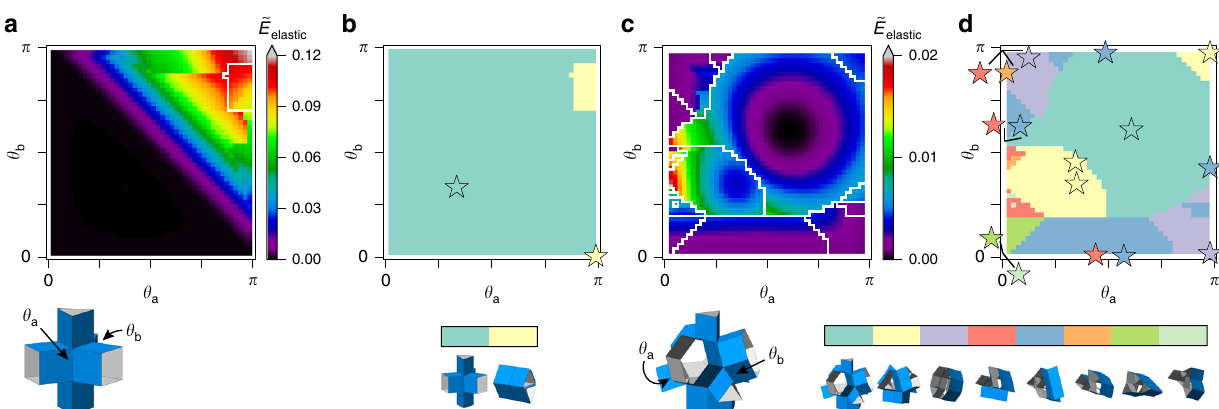
Fig. 3 Projected energy landscapes and state diagrams for two prismatic structures. These landscapes and states diagrams were obtained by running multiple simulations with different loads applied to two hinges. The studied prismatic structures are based on a a triangular prism and c a truncated tetrahedron. Here, we fold the structures in two steps: fi rst we fold hinge θ energy of the fi nal state, and repeat this process for all possible combination of angles. The results are then presented as a 2D projection of the energy landscape. The corresponding state diagrams are shown in b and d , which are obtained by relaxing the prismatic structure from the folded con fi gurations. The star symbols indicate the values of the angles θ